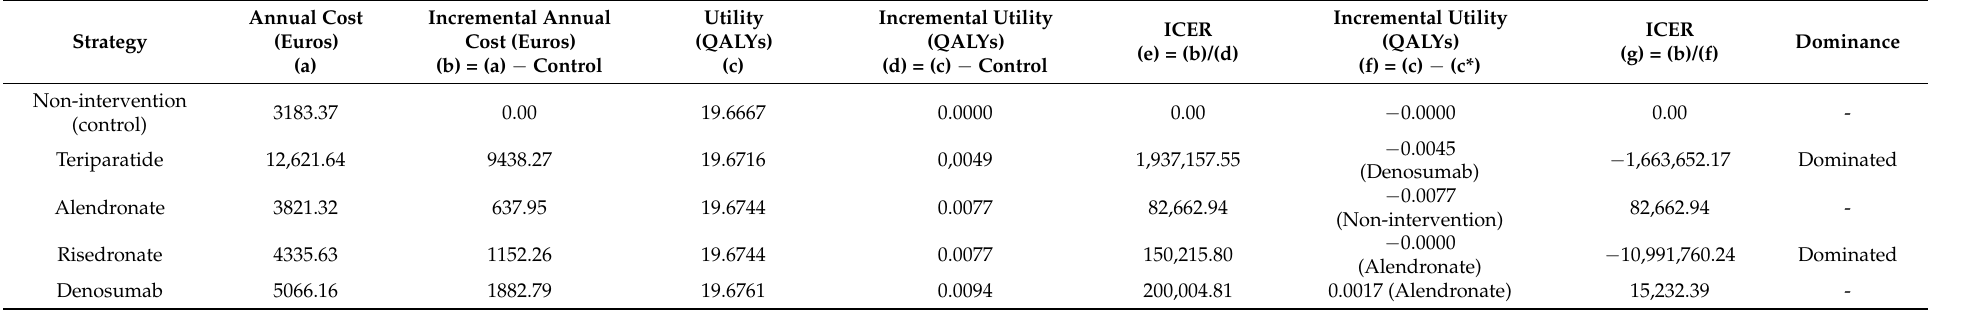
Table 9. The ratio of the increment in cost over the increment in effectiveness (ICER). Teriparatide administered at the start of the